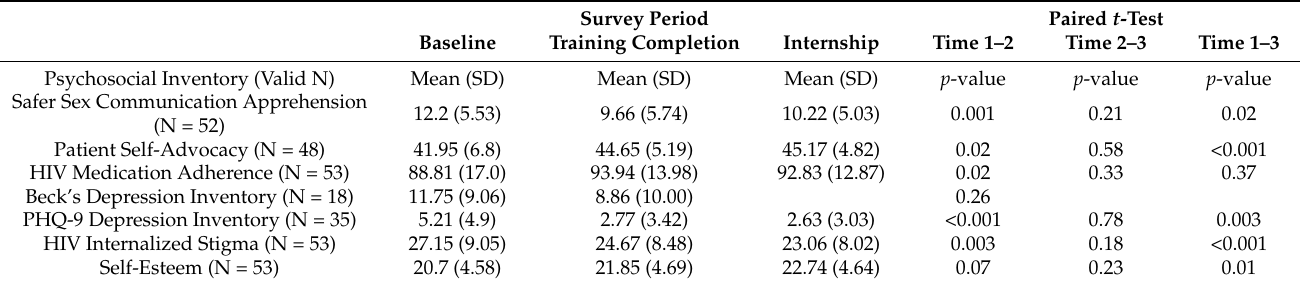
Table 7. Change in psychosocial inventories for internship